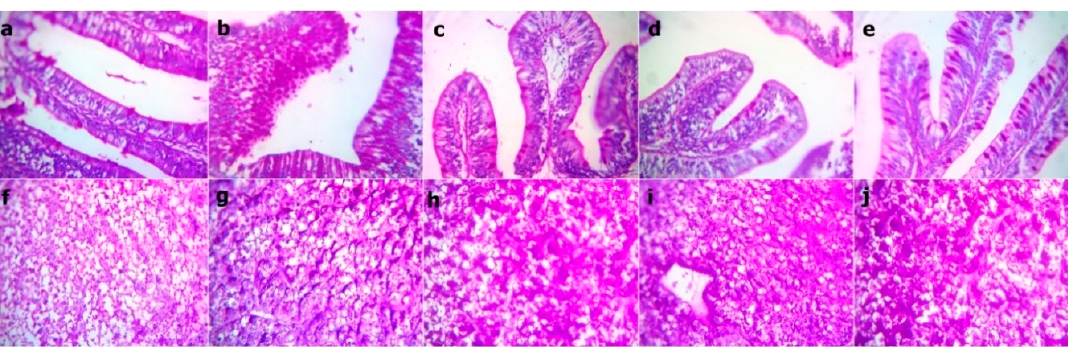
Figure 6 Representative photomicrograph of the Periodic Acid Schiff stained sections at magnification 400x from the fish intestine and liver before bacterial challenge showing the red stainable intestinal goblet cells and mucus within the limit and no difference between all groups. Red granular stainable materials (glycogen) distributed in the hepatocyte cytoplasms are within the normal limit, but they are mildly increased in the WPC41.6 and WPC55.5 liver sections. ( a , f ) WPC0, ( b , g ) WPC13.8, ( c , h ) WPC27.7, ( d , i ) WPC41.6, ( e , j ) WPC55.5.